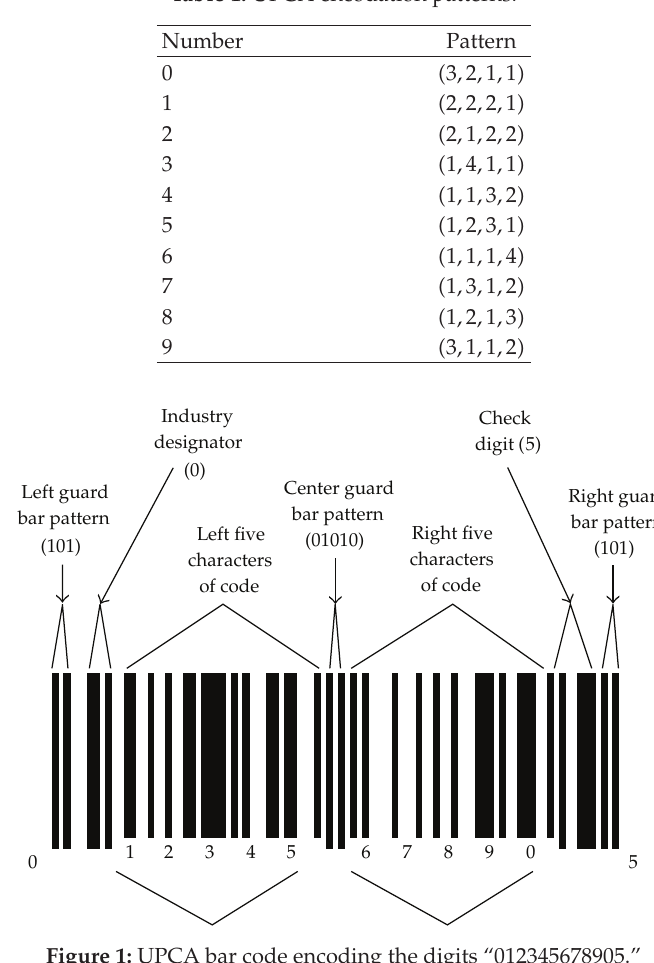
Table 1: UPCA encodation patterns.